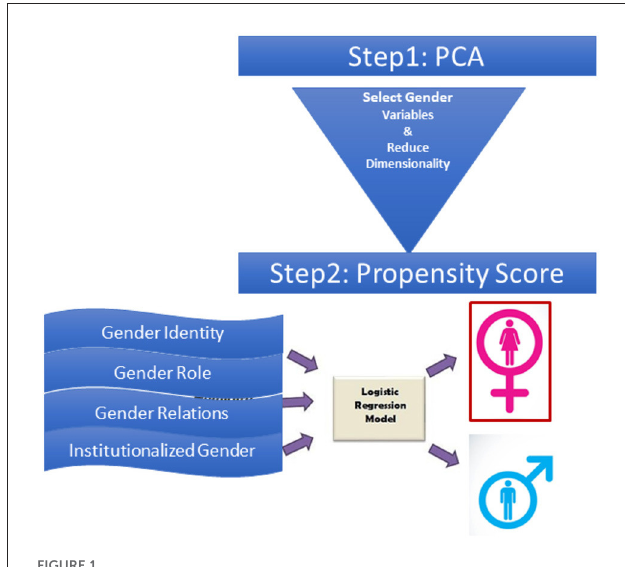
FIGURE1 Gender score calculation method. Gender index was calculated through the construction of a propensity score, which was derived from coefficient estimates in the final logistic regression model with biological sex as dependent variable and gender related variables as covariates. The propensity score for each person was defined as the conditional probability of being a female vs. a male based on gender-related variables. This score ranges from 0 to 1, with higher scores relating to characteristics traditionally ascribed to